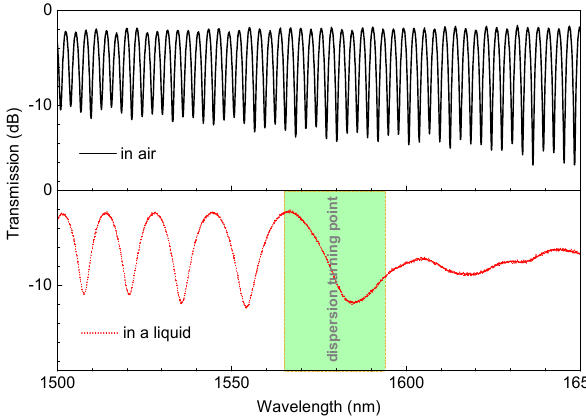
Figure 2. Variation of the interference spectra of the TTMF when immersed in air and a liquid.